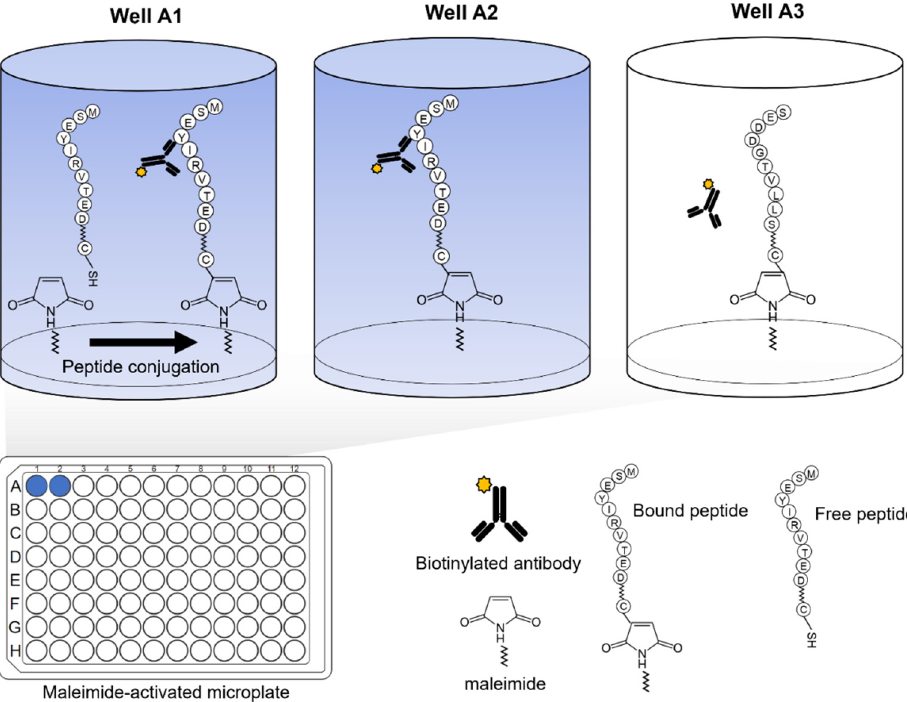
Figure 3. Microplate-based epitope mapping using maleimide-coated plates. Peptide sequences are coated separately on the well surfaces and bind through covalent interaction of cysteine with maleimide. Protein interactions are detected through a visible colorimetric reaction on the well.